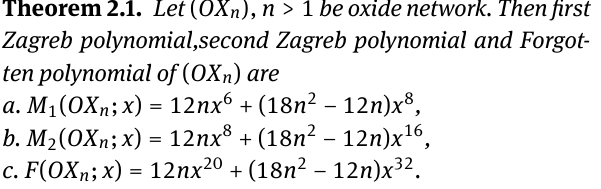
We reserve the symbol ( OX ), n > 1 for oxide network n of dimension n . From figures (1-2) it is obvious that the or- derandsizeof( OX )isrespectively,9 n 2 +3 n and18 n 2 .An- n other noticeable observation is the fact that ( OX ), n > 1 n has only vertices of degree 2 and 4. In this paper we com- pute first Zagreb polynomial, second Zagreb polynomial, Forgotten polynomial and some topological indices such as Hyper-Zagreb index, first and second multiple Zagreb indices, Forgotten index, Albert index, Bell index, IRM(G) and M ( L ( G )). We also compute first and second Zagreb 1 coindices, F-index of complement of ( OX ), F-coindex of n ( OX ) and F-coindex of complement of oxide networks. We n also give graphical analysis of each index and